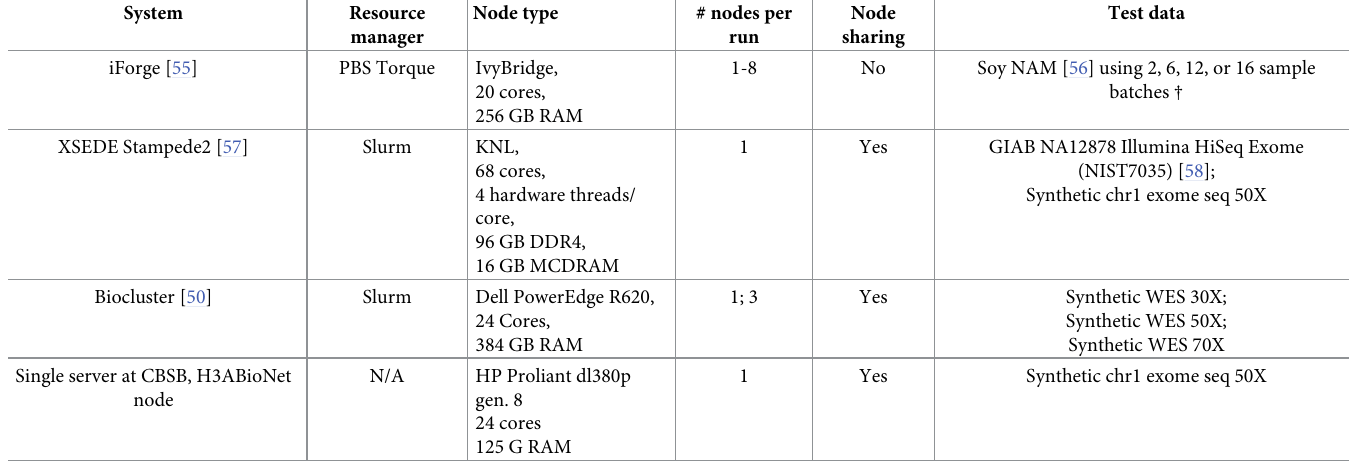
Table 2. Swift/T delivers on its promise of portability and scalability. Synthetic data were generated using the NEAT synthetic read simulator [54]. Node sharing column indicates whether the cluster permits jobs to share the same node.